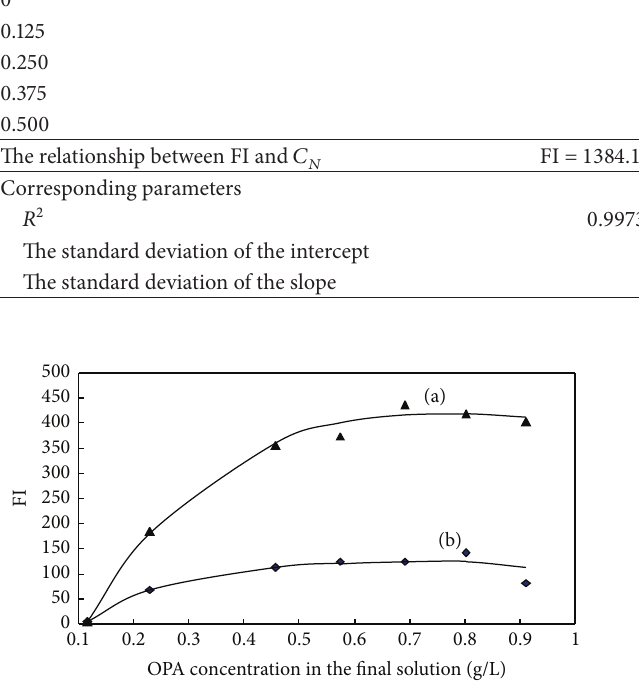
Figure 3: Effect of OPA concentration in the final solution on the reaction of OPA-NH 3 -sulfite ((a) 0.25 𝜇 mol/L, (b) blank).